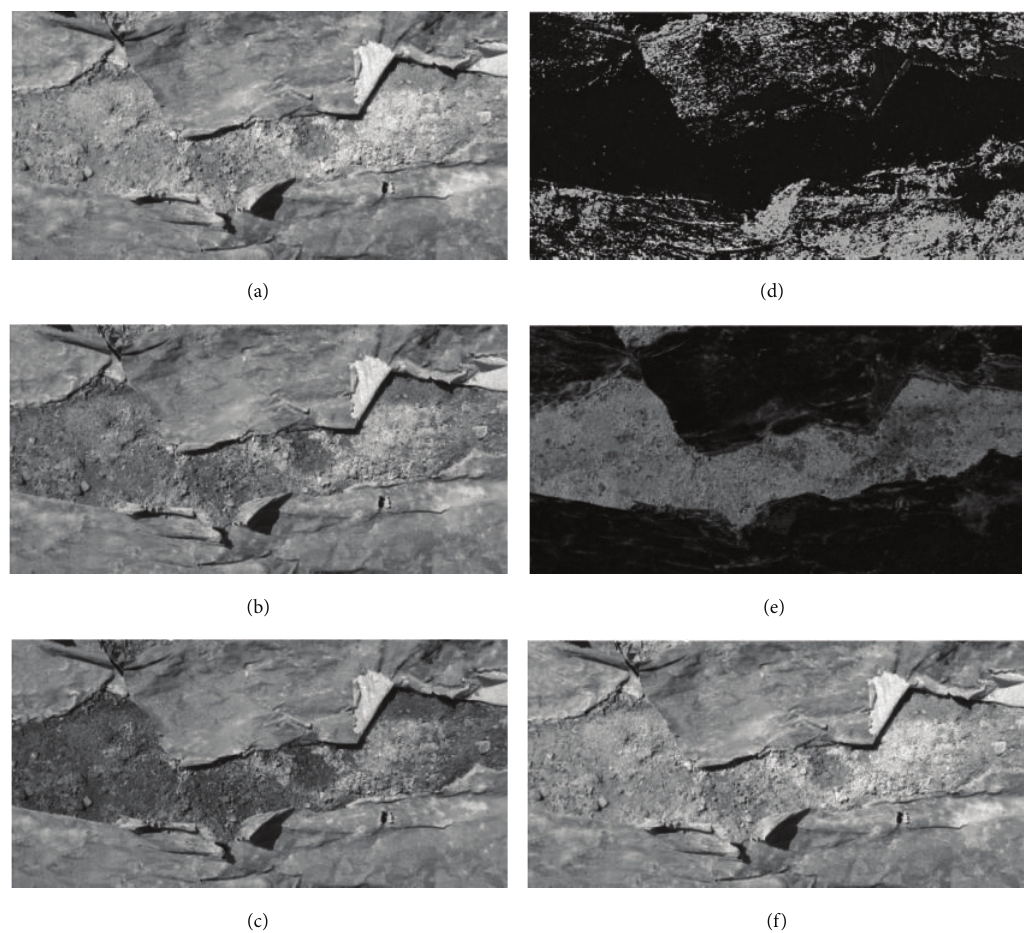
Figure 2: Representation of the original image shown in Figure 1 in the RGB system (left column) and in the HSV system (right column). (a) Red plane, (b) green plane, (c) blue plane, (d) hue plane, (e) saturation plane, and (f) value